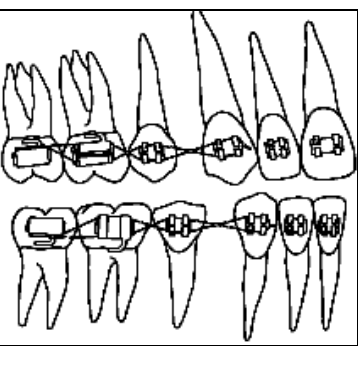
Evidence about mechanics of space